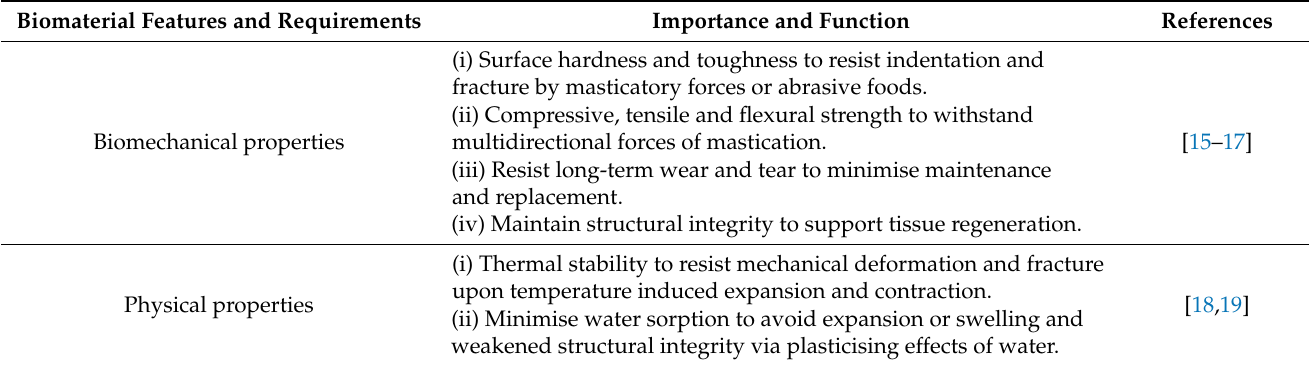
Table 1. Essential features of antimicrobial and antifouling materials for dental applications. Biomaterial Features and